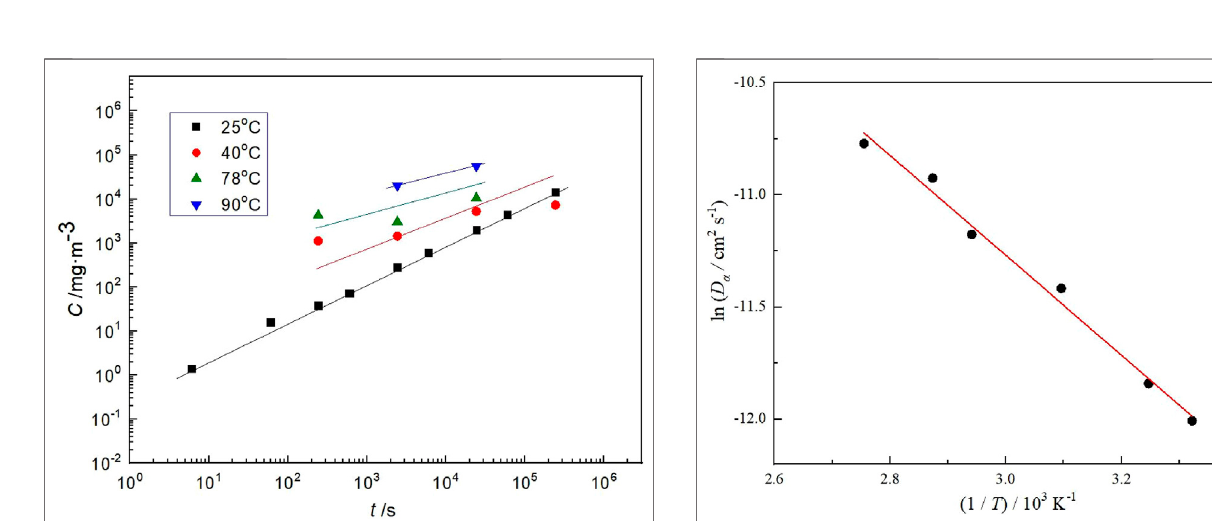
Frontiers in Materials |